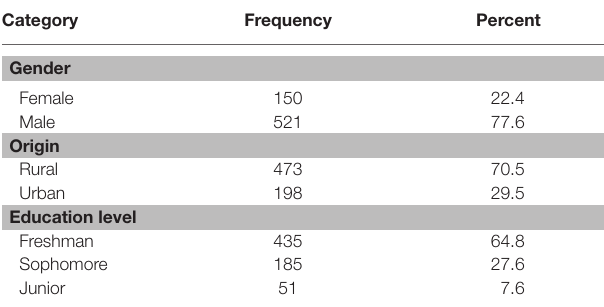
TABLE 1 | Summary of the sociodemographic information of the